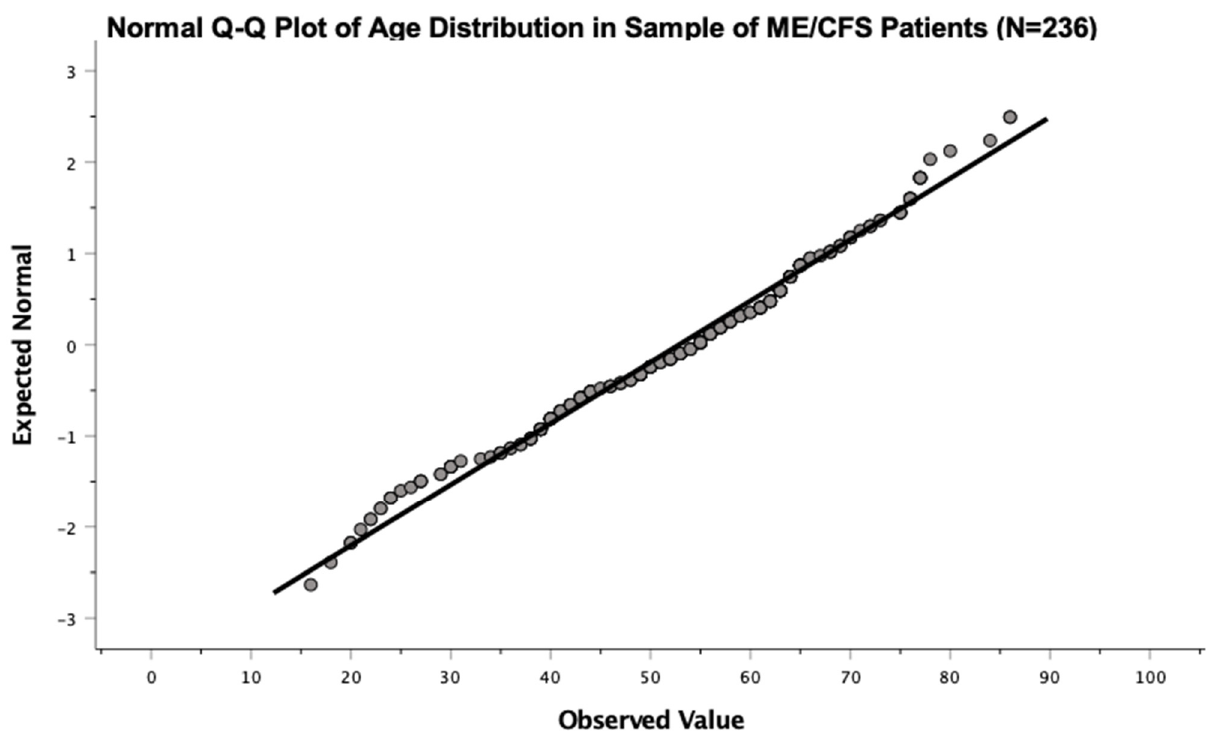
Figure 8. Normal quantile-quantile plot of age distribution in ME/CFS patients showed normality fit.